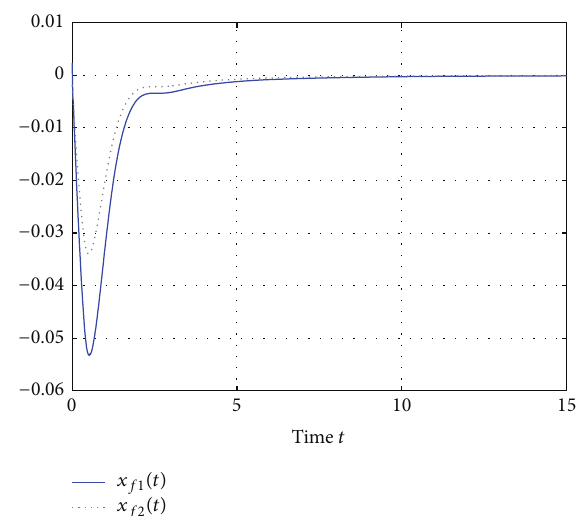
Figure 2: Response of the filter state 𝑥 𝑓 (𝑡)